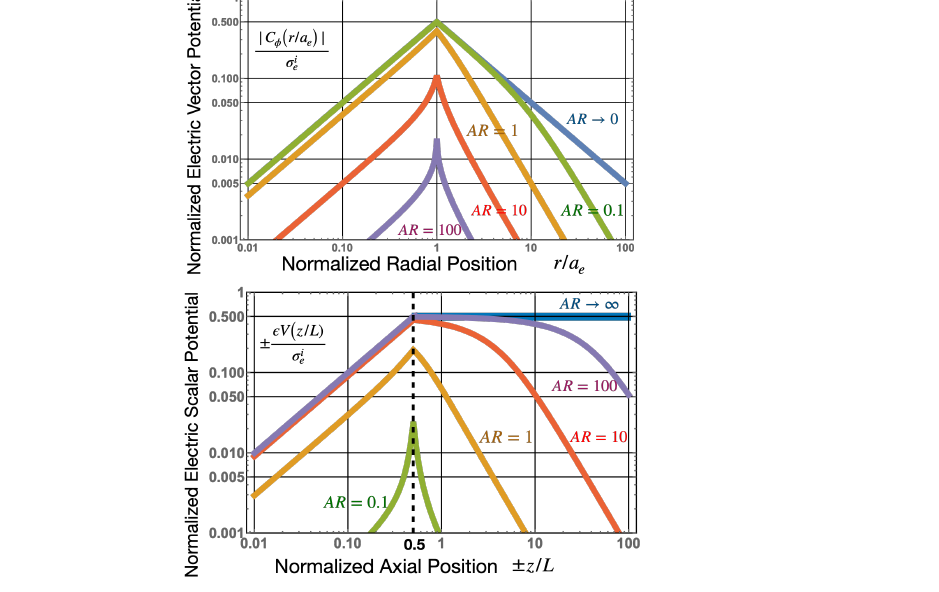
is zero for all z . z = 1, is continuous, while a e = ± 1 L 2